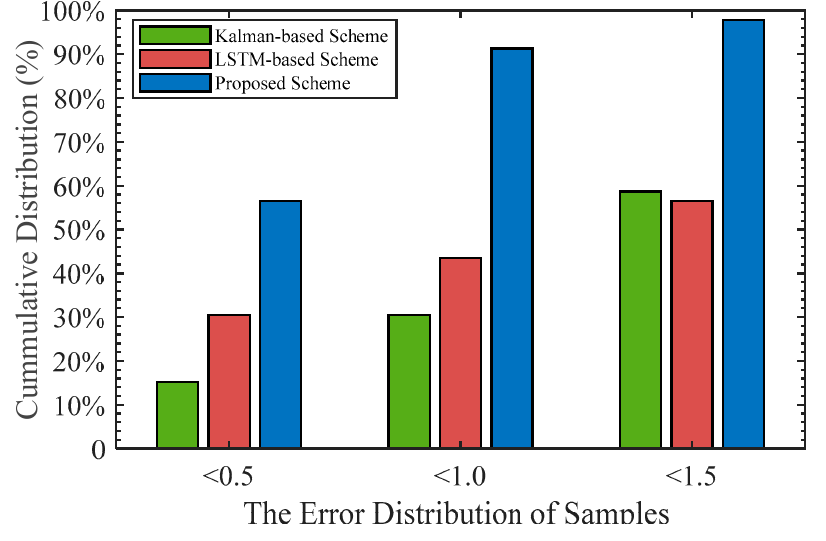
Figure 7. Agents’ movement positions.